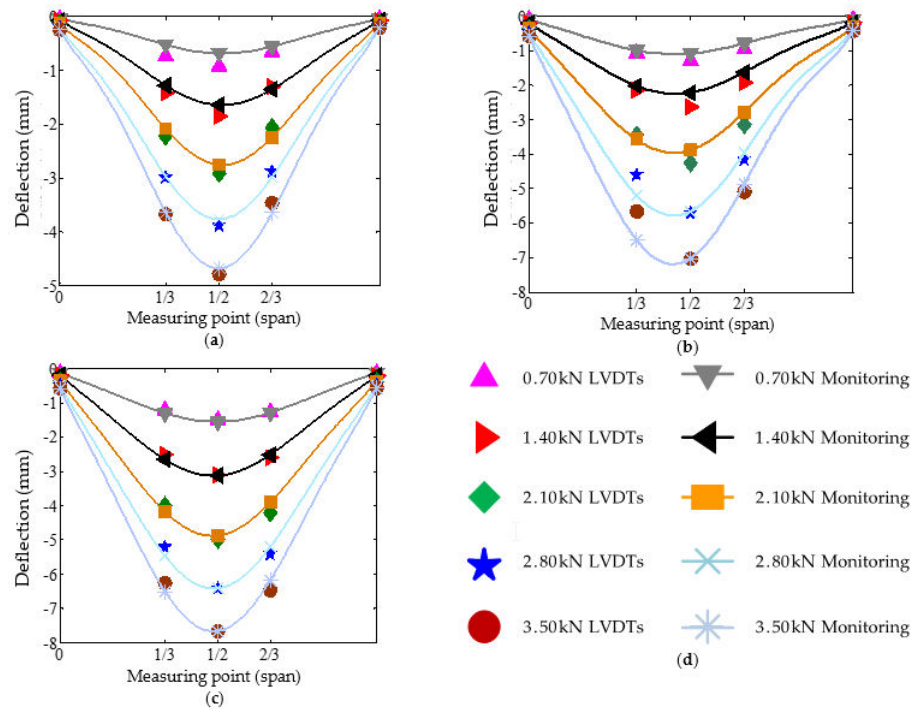
Figure 11. The comparison of beam deflection under concentrated loading: ( a – c ) Comparison of L1~L3, respectively; ( d ) Legend of